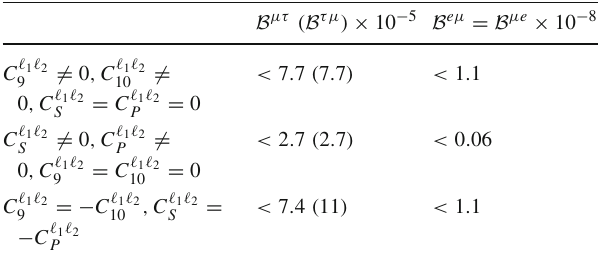
Table 5 Upper limits for the branching ratio of (cid:2) b → (cid:2) LFV decays obtained in a model independent way by considering their mesonic counter parts. Bounds are at 90% CL. For the first two scenarios, the branching ratios are independent of the charge configuration. However for the SMEFT scenario this is not the case anymore, hence we present both branching ratios for μ − τ + and in brackets τ − μ +